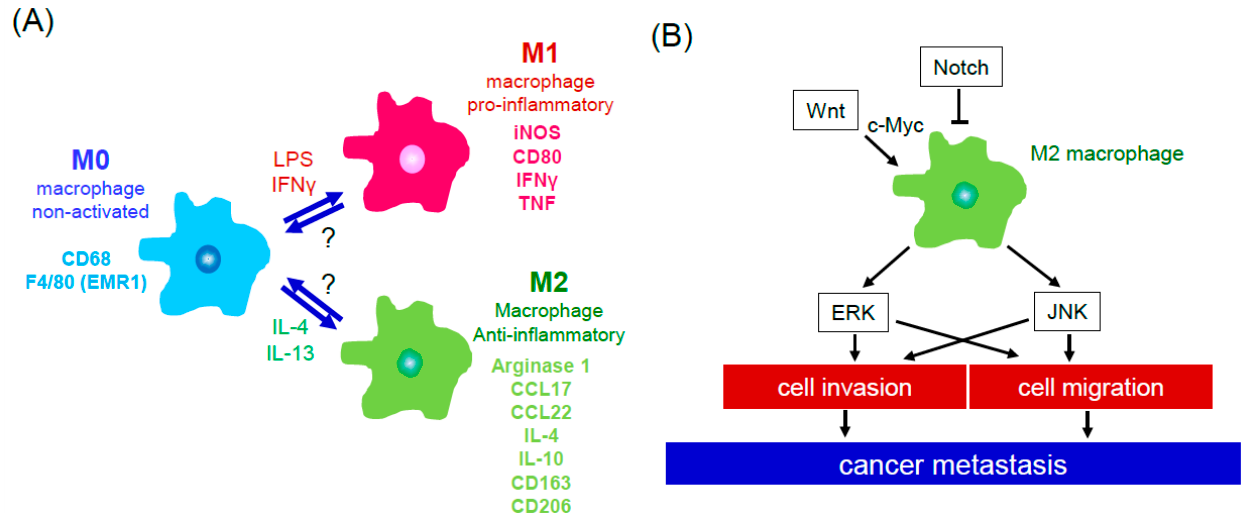
Figure 1. Macrophage polarization and M2 macrophage-associated signaling pathways that contribute to cancer dissemi- nation. ( A ) Non-activated macrophages (M0 macrophages) are polarized to pro-inflammatory/M1 macrophages which specifically express several molecules, including iNOS, CD80, IFN γ , and TNF, in the presence of LPS and IFN γ . In the presence of IL-4 or IL-13, M0 macrophages are polarized to anti-inflammatory/M2 macrophages which specifically express arginase 1, CCL17, CCL22, IL-4, IL-10, CD163, and CD206, and contributing to tissue repair process and tumor development. ( B ) M2 macrophages potentiate cancer metastasis through activation of ERK and JNK signaling that upregulates cell migration and invasion. Notch signaling inhibits M2 macrophage polarization. Wnt signaling can polarize macrophages to a M2 subtype by activation of c-Myc. Abbreviation: ERK: extracellular signal-regulated kinase; JNK: c-Jun N- terminal kinase. Abbreviation: EMR1: EGF-like module-containing mucin-like hormone receptor-like 1; iNOS: inducible nitric oxide synthase; IFN γ : interferon gamma; TNF: tumor necrosis factor; LPS: lipopolysaccharide; IL-4: interleukin-4; IL-10: interleukin-10.